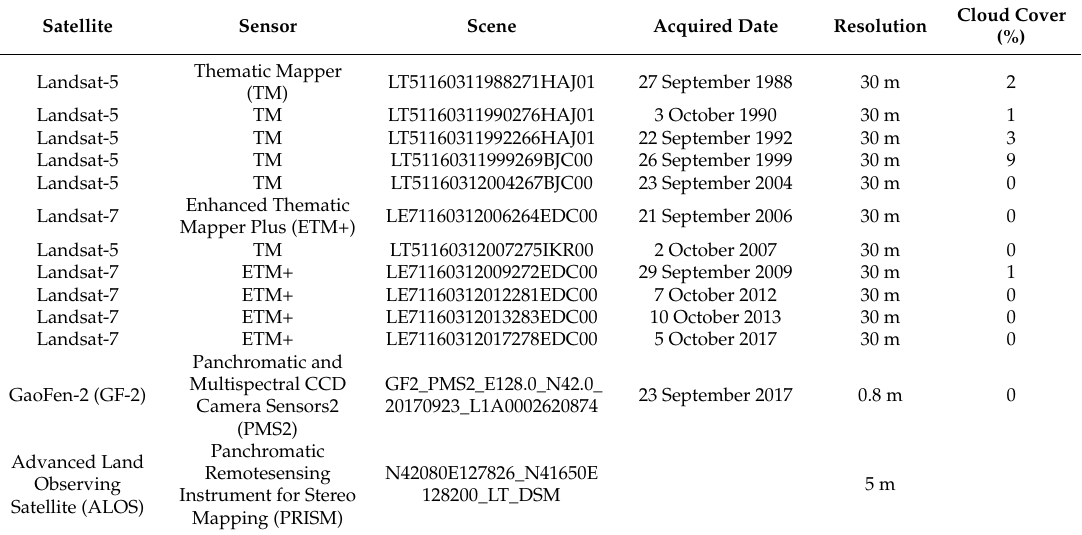
Table 1. List of satellite